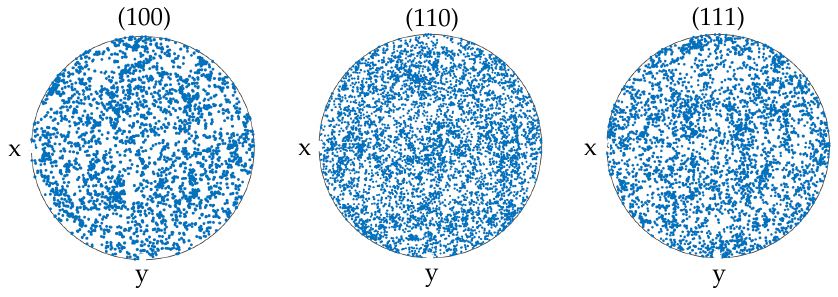
Figure 9. (100), (110) and (111) pole figures of the EBSD data from Figure